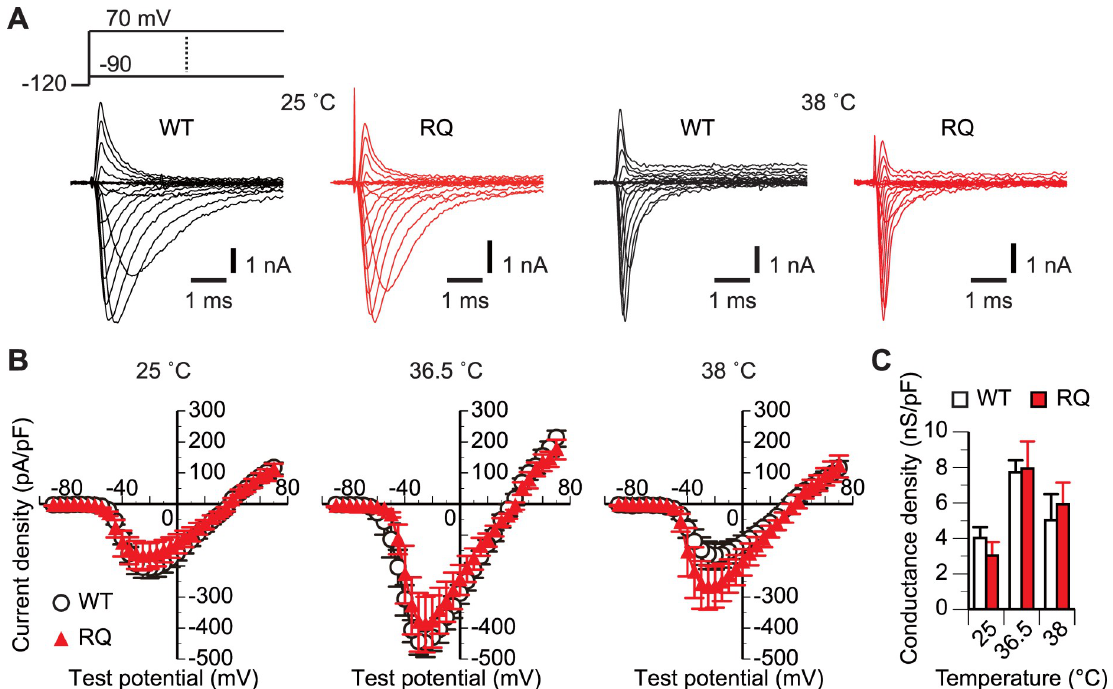
Fig 1. SCN5A(R1193Q) did not affect the whole-cell conductance at any tested temperature. (A and B) Representative traces (A) and mean I-V plots (B) of I Na of WT and RQ cells continuously perfused with bath solutions at the indicated temperatures. Schematic in panel A shows the voltage protocol. The test potential was incremented in 5-mV steps. For simplicity, current responses to some test potentials are omitted from the traces. n, 10–11 WT cells and 9–11 RQ cells for each condition. Error bars indicate ± SEM throughout the figures unless otherwise stated. (C) Comparison of mean whole-cell conductance densities estimated from the slope of the linear region of the I-V plot for each cell. p > 0.05 between WT and RQ cells for all temperatures (unpaired t